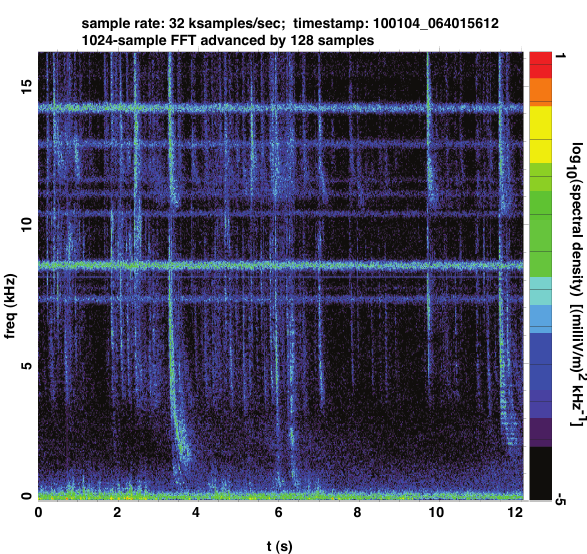
Fig. 12. Similar to Fig. 1, but for a burst recording of 4 January 2010 yielding no peaks.